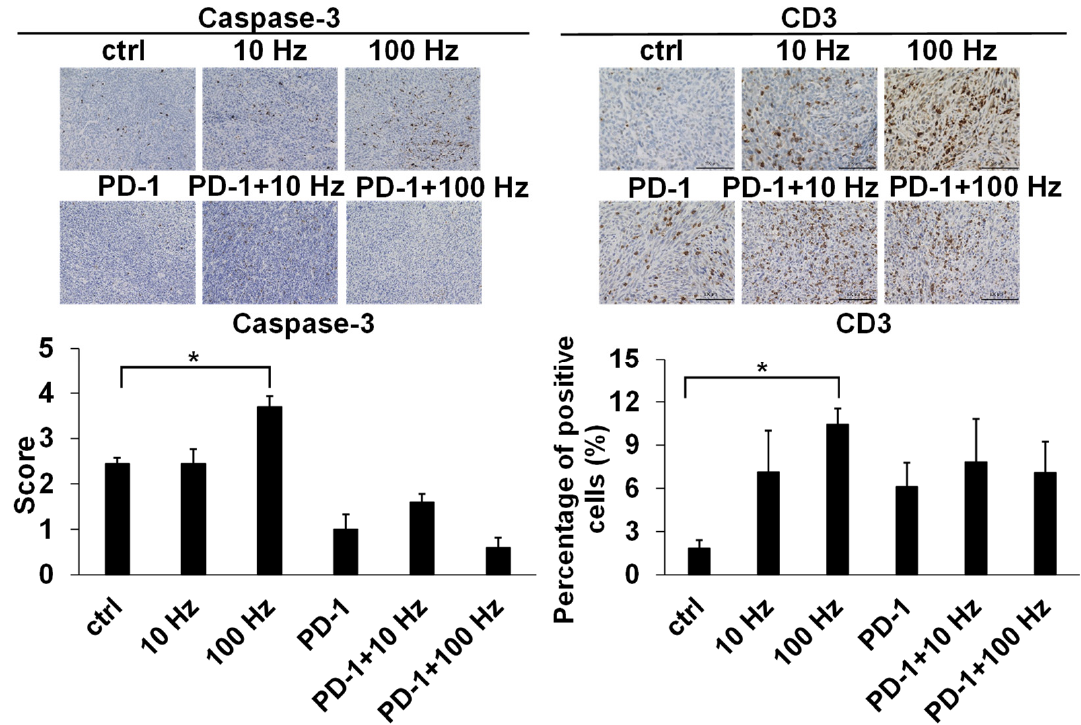
Figure 5. Immunohistochemical analysis of TRAMP-C2 mice tumors after US irradiation and ICIs treatment. After performing US irradiation treatment and US + ICIs combination treatment on TRAMP-C2 mice, immunohistochemical staining was performed on the removed tumor. IHC analysis showed that the expression level of cleaved Caspase-3 and the ratio of the number of CD3 positive cells were both significantly increased by US irradiation at 100 Hz (*: p < 0.05).